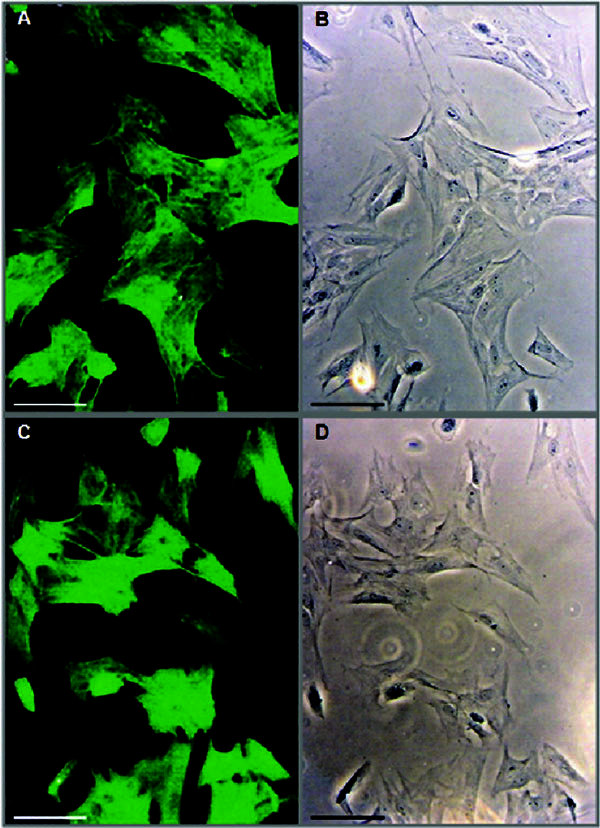
Characterization of airway smooth muscle cells by
α-actin smooth muscle immunofluorescence: Specific
primary antibody against α-actin (1:100) and
FITC-conjugated secondary antibody (1:50) were used. Panels (C,
OVA) and (A, CONTROL) represent the typical photography records of cells
culture under fluorescence microscope. Panels (D, OVA) and (B, CONTROL)
are phase-contrast microscopy records. Magnification: × 200. Bar =
150 μm. The immunolabeling was performed in ASMCs from
different trachae from OVA and CONTROL rats (n = 3) for each
experimental condition.